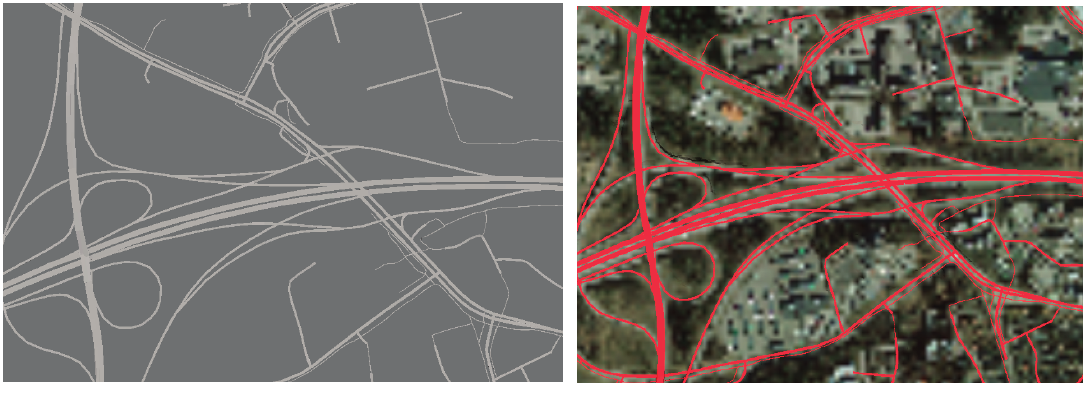
Figure 26. The result of 3D road network reconstruction. ( Left ) 3D road networks; ( Right ) 3D roads overlaid on the NLS orthophoto (roads in